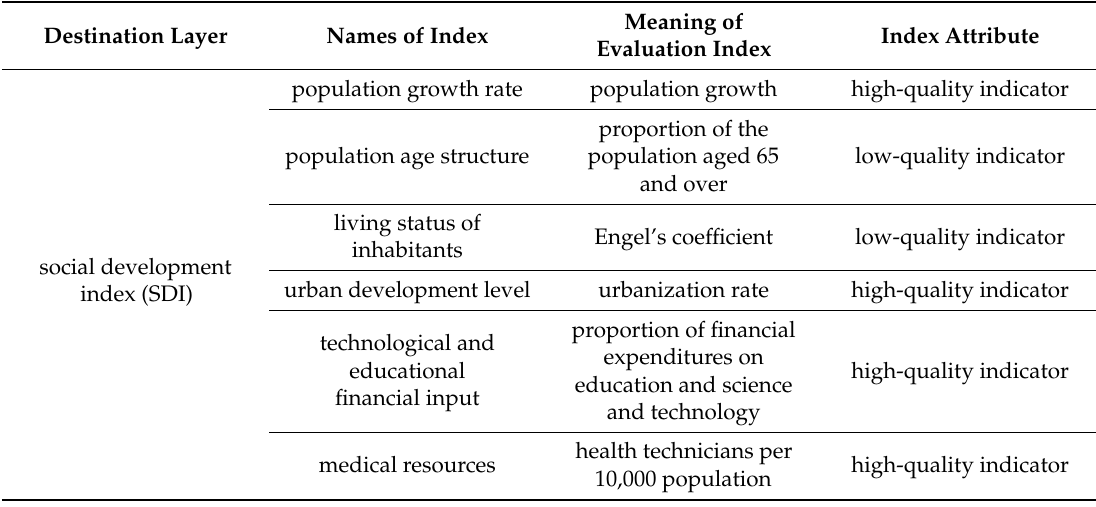
Table 1. Components of the indicator system of the social development